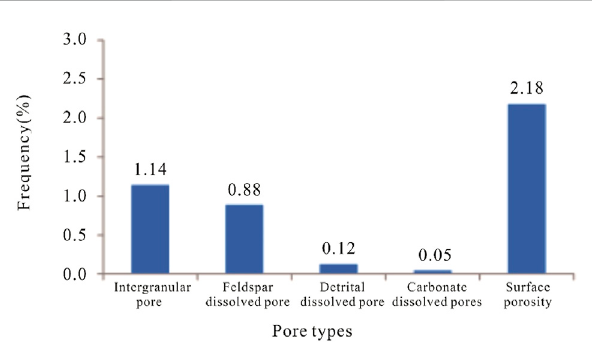
FIGURE 5 Bar chart of the pore types developed in the sandstones of the Gaotaizi oil layer in the Qijia